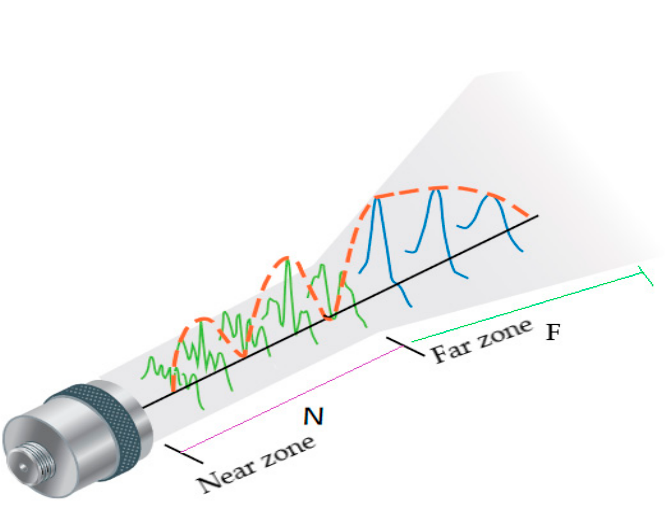
Figure 3. Transducer wave zones [84].